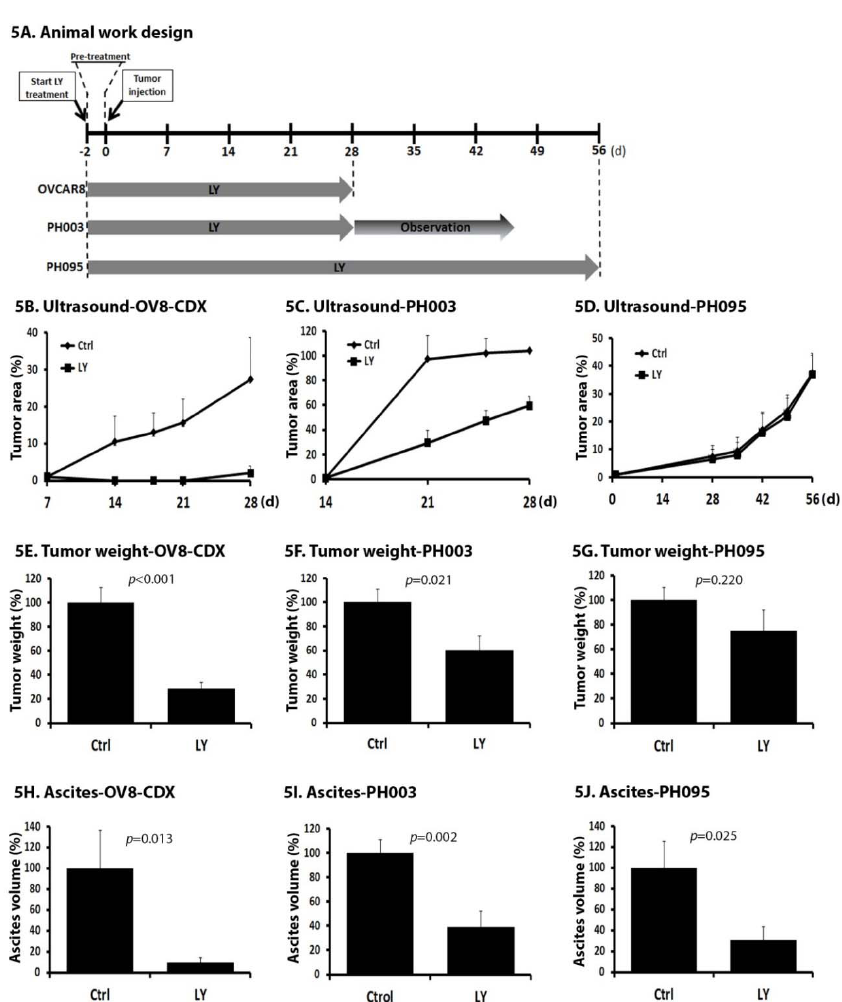
Figure 5. LY delays OC tumor growth and ascites development in vivo. ( A ) Scheme of animal model (cell line ‐ derived and patient ‐ derived xenografts) study design. LY treatment was initiated 2 days prior to tumor injection followed by continuous drug treatment. ( B – D ) Percentage of change in tumor area over time in three models, respectively. ( E – G ) Percentage of change in final tumor weights measured at harvest in three models, respectively. ( H – J ) Percentage of change in ascites volume measured at harvest in three models, respectively.